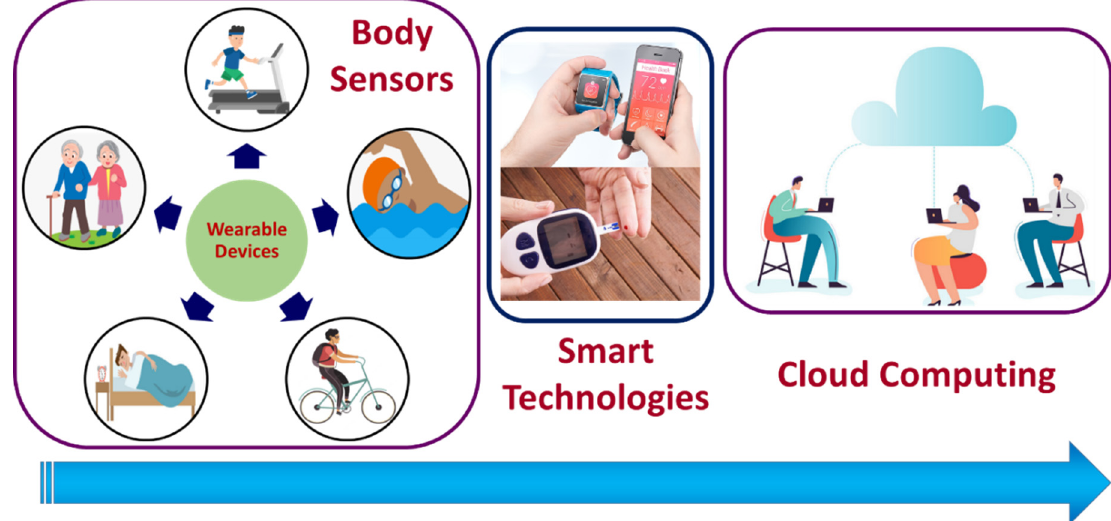
Figure 1. Schematic representation of IoMT devices and cloud data transfer. Body sensors are those that are directly attached to the body, embedded in fabric, or implanted into the human body. Smart sensing technology is used to analyze the collected data and transfer it to the cloud. The cloud serves as a bridge between body sensors and the recipient of the output.